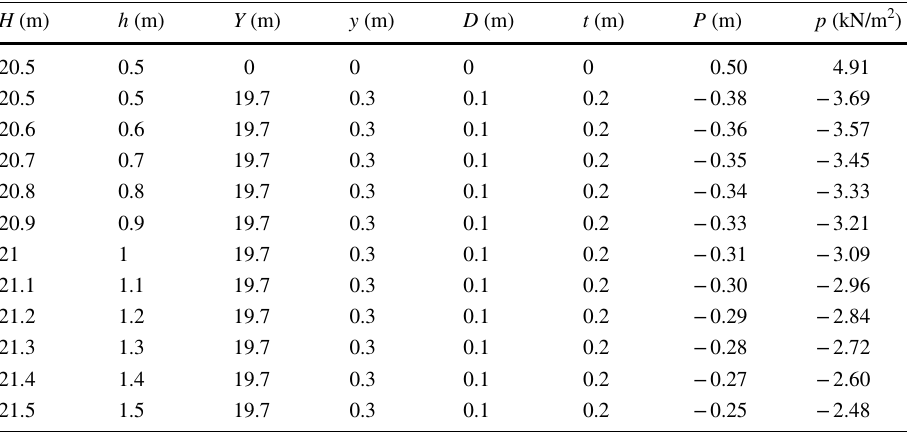
Table 3 Effect of hydraulic parameters on uplift pressure under the canal